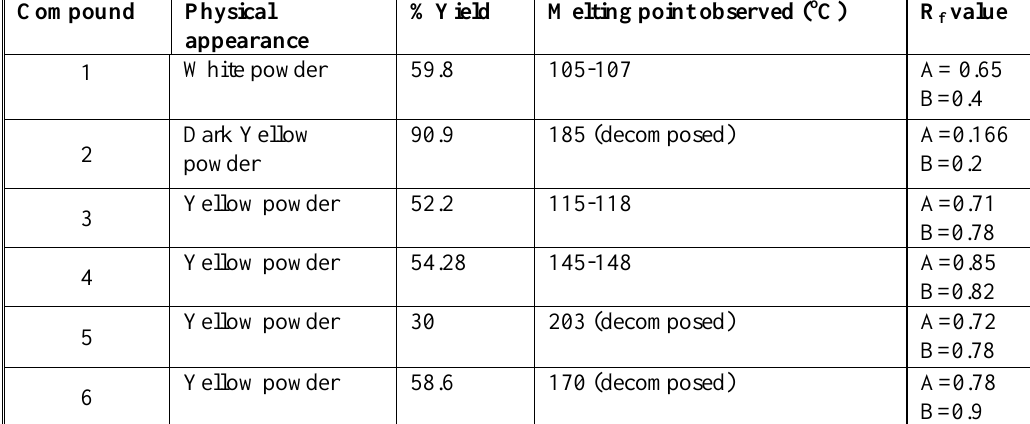
Table(1): Physical data of the synthesized compounds. Compound